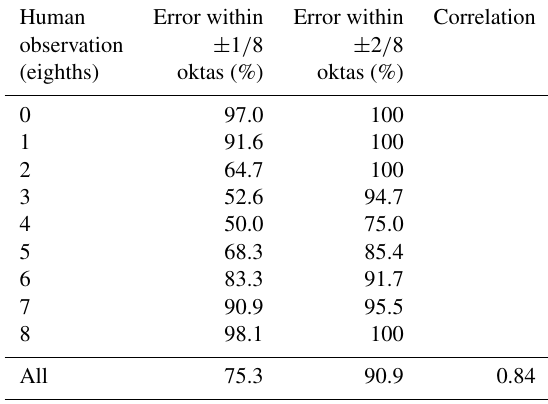
Table 2. Comparison of derived cloud cover between SegCloud and human observation. The cloud cover provided by human observa- tion is set to ground truth, and the error is defined as the cloud cover estimated by SegCloud minus the ground truth. The table presents the percentages of the error within ± 1 / 8 oktas and the error within ± 2 / 8 oktas. The correlation coefficient between SegCloud and hu- man observation is also